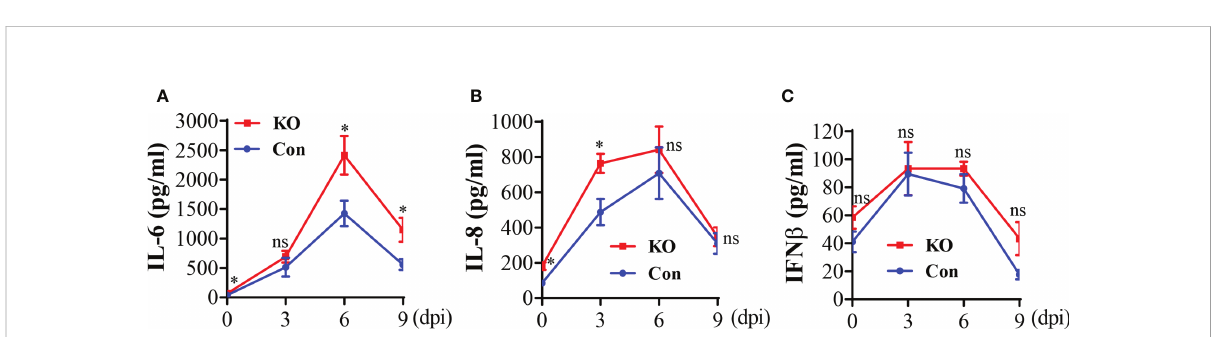
FIGURE 7 A general Runx3 KO in adult mice increases lung production of pro-in fl ammatory cytokines in response to IAV Infection. Sex-and age-matched littermate control (Con) and Runx3 KO mice were infected with 1 LD 50 of H1N1 PR8 strain and BALFs were collected and subjected to ELISA for IL-6 (A) , IL-8 (B) and IFN b (C) . Results are presented as means ± SE. IL-6, n = 5-8; IL-8; n = 6-9; IFN b , n = 7. Unpaired Student ’ s t test was performed in (A – C) *p<0.05 vs control mice. NS, no signi fi